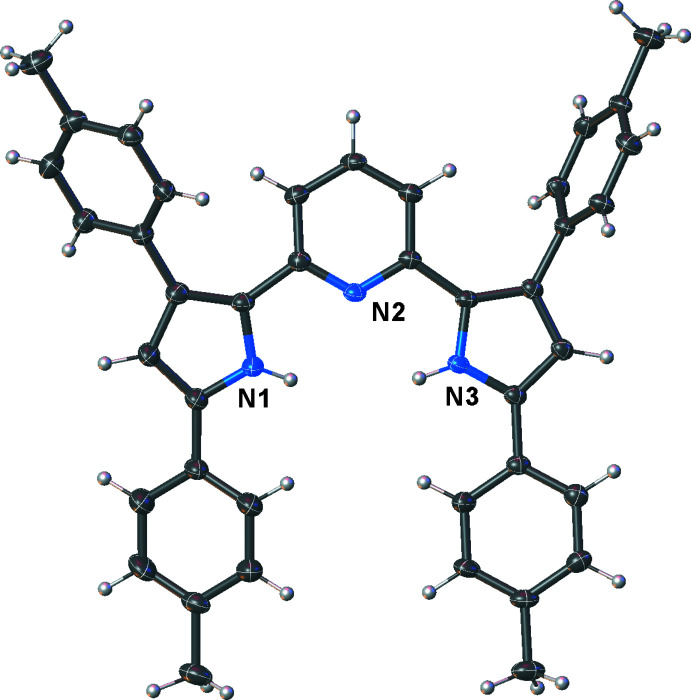
Mol­ecular structure of [pyrr2Py]H2 with displacement ellipsoids drawn at the 50% probability level.